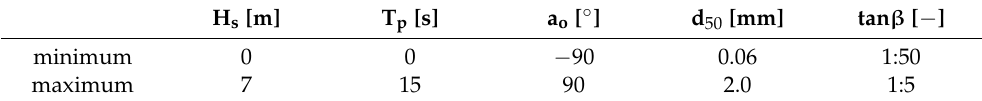
Table 1. Lower and upper boundaries of the Input Parameters (IP) are